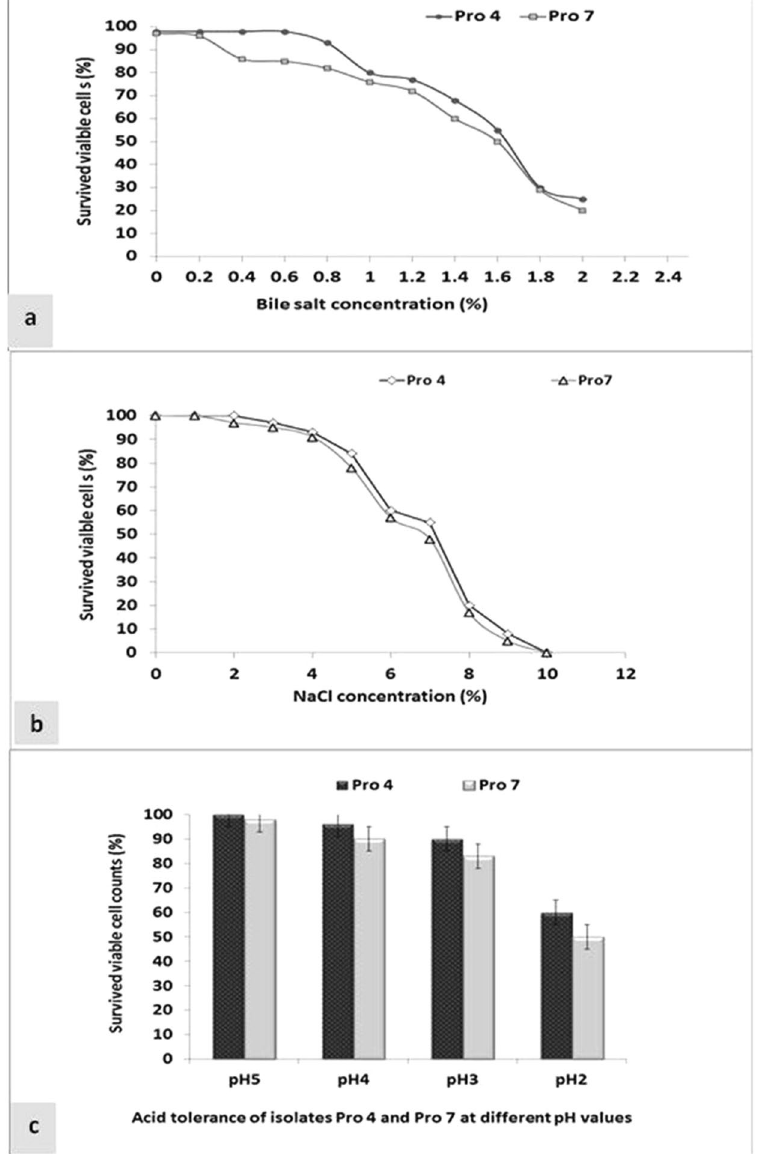
Figure 3. Probiotic properties of selected isolates, bile tolerance ( a ), NaCl tolerance ( b ) and acid tolerance ( c ). Each value represents mean of sample ± SD for n =